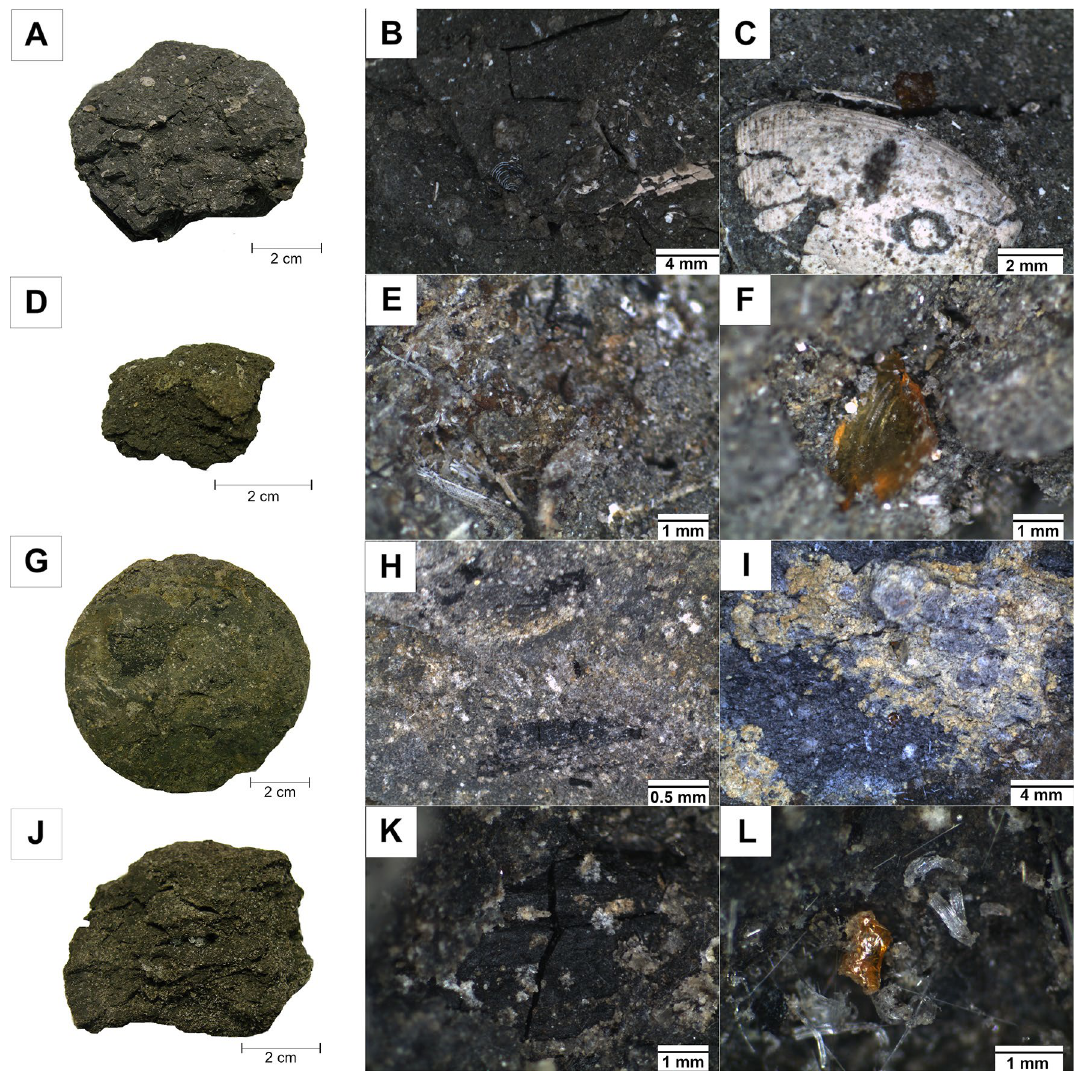
Figure 3. Macrophotographs of the studied rocks ( A , D , G , J ) and a stereoscopic microscope images ( B , C , E , F , H , I , K , L ). ( A ) Macrophoto of SC1 sample from the depth 19.5 mbgl; ( B ) stereoscopic microscope image of SC1 sample with fragments of carbonate shells; ( C ) carbonate shell (probably Ostracoda) and the fossil resin in the rock matrix (SC1 sample); ( D ) macrophoto of SC2 sample from the depth 19.85 mbgl; ( E ) needle-shaped crystals of gypsum in the rock matrix (SC2 sample); ( F ) fossil resin in the matrix (SC2 sample); ( G ) macrophoto of SC3 sample from the depth 20.25 mbgl; ( H ) lenses of carbonized plant detritus in the matrix (SC3); ( I ) the native sulfur on the matrix (SC3); ( J ) macrophoto of SC4 sample from the depth 20.5 mbgl; ( K ) fracture filled with coal in the rock matrix (SC4); ( L ) needle-shaped crystals of gypsum and fossil resin grain in the rock matrix